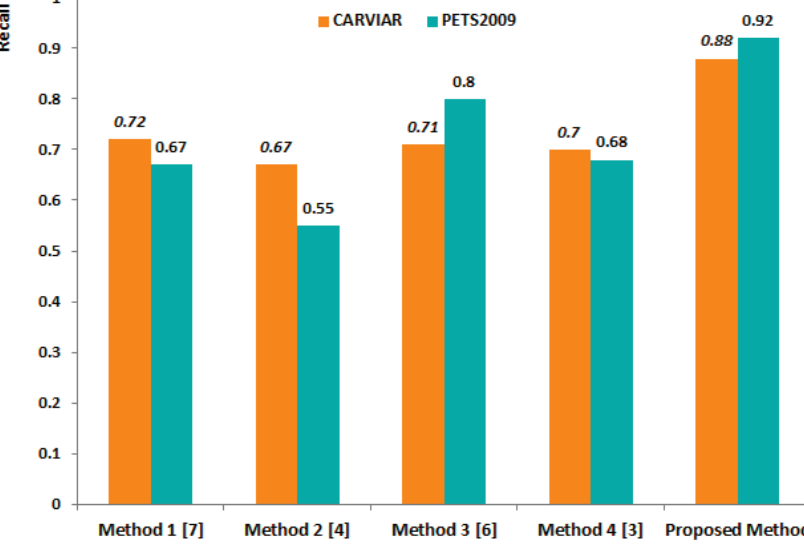
Figure 6. Performance comparison of the proposed method and the four other methods using different image-scaling methods.